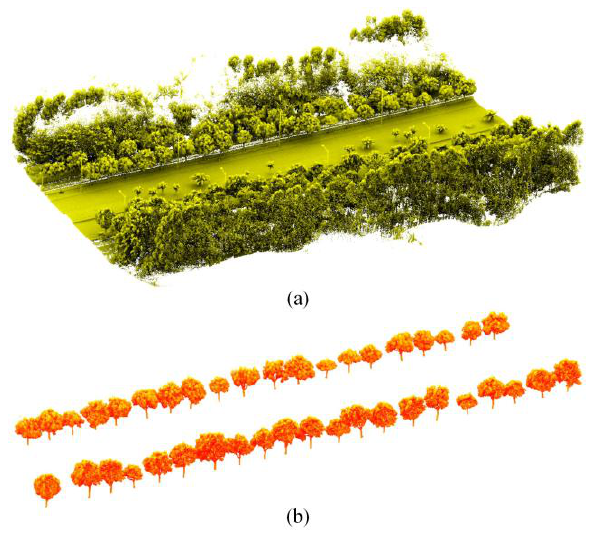
Figure 6. (a) Dataset II, and (b) extracted 3D trees.